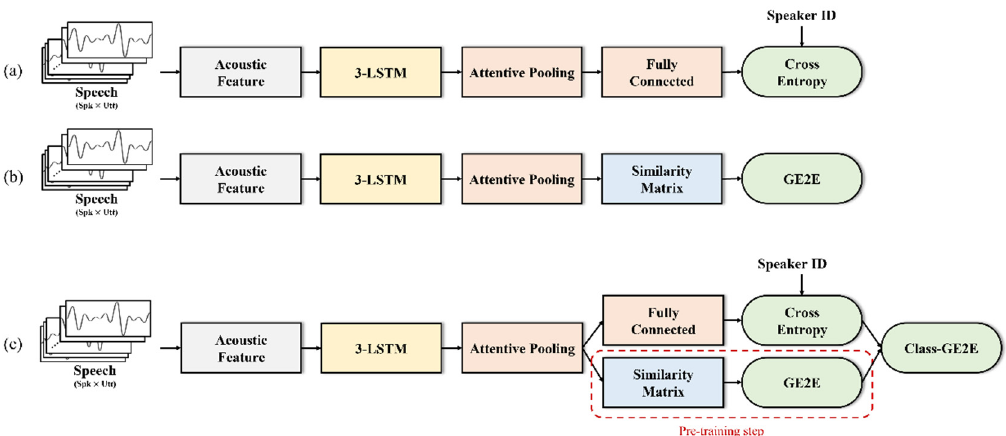
Figure 2. ( a ) Classification model architecture using cross-entropy loss, ( b ) metric-based model architecture using GE2E loss, and ( c ) model architecture that re-trains by adding a classifier to the model pre-trained with GE2E loss, such as the model proposed in this paper.